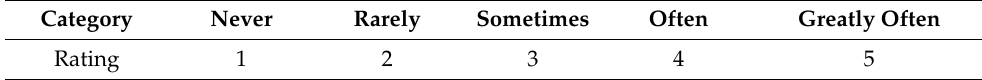
Table 1. Likert scale for importance/frequency of occurrence.